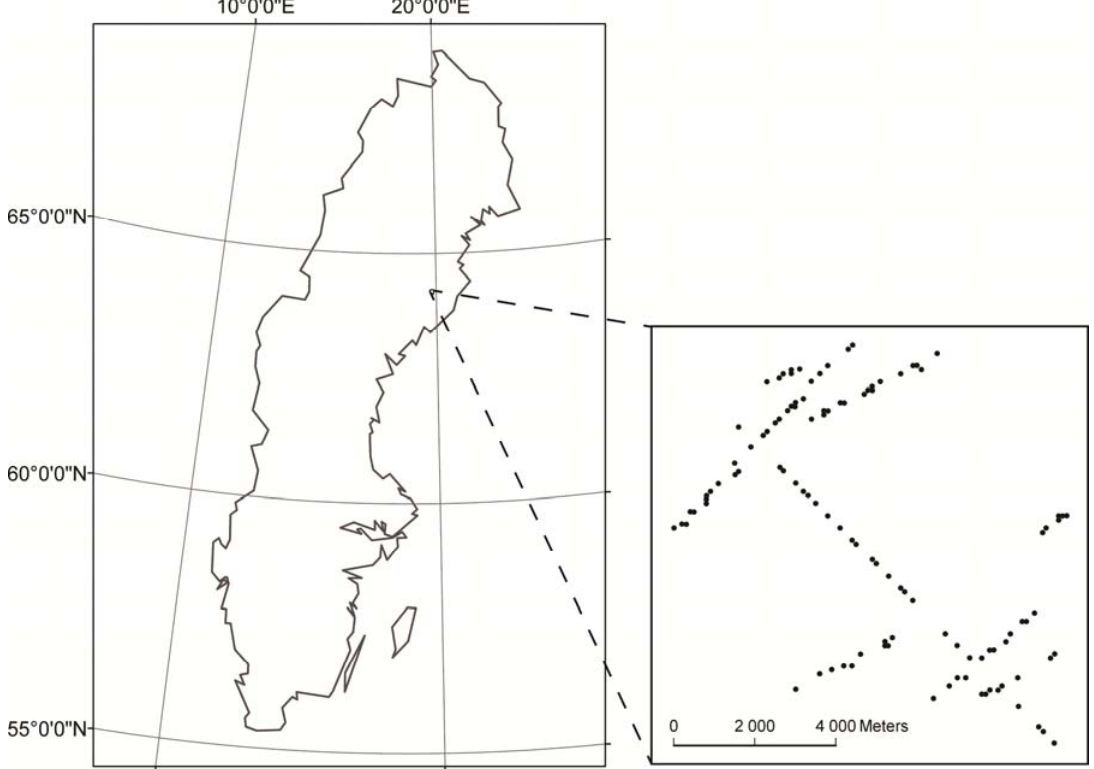
Figure 1. Study area in Sweden (64°14'N, 19°50'E) and positions of the field